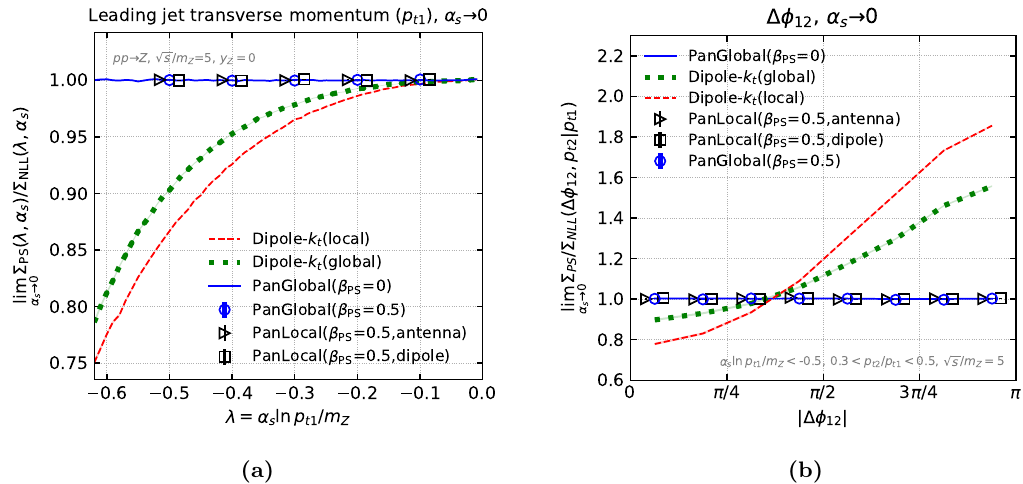
Figure 3. (a) Ratio of the shower and NLL results for the cumulative distribution for the hardest jet transverse momentum, p t 1 , with − 0 . 62 < λ < 0 and α s → 0 for pp → Z events. (b) Difference in azimuthal angles between the two leading jets in a pp → Z event, where the first jet has λ = α s ln p t 1 /m Z ≤ − 0 . 5 , while the second one has 0 . 3 ≤ p t 2 ≤ 0 . 5 . In the α s → 0 limit, p t 1 the λ < − 0 . 5 condition effectively fixes λ = − 0 . 5 . In both plots, we have shifted the horizontal locations of the markers for the two PanLocal showers, so as to avoid having all the symbols